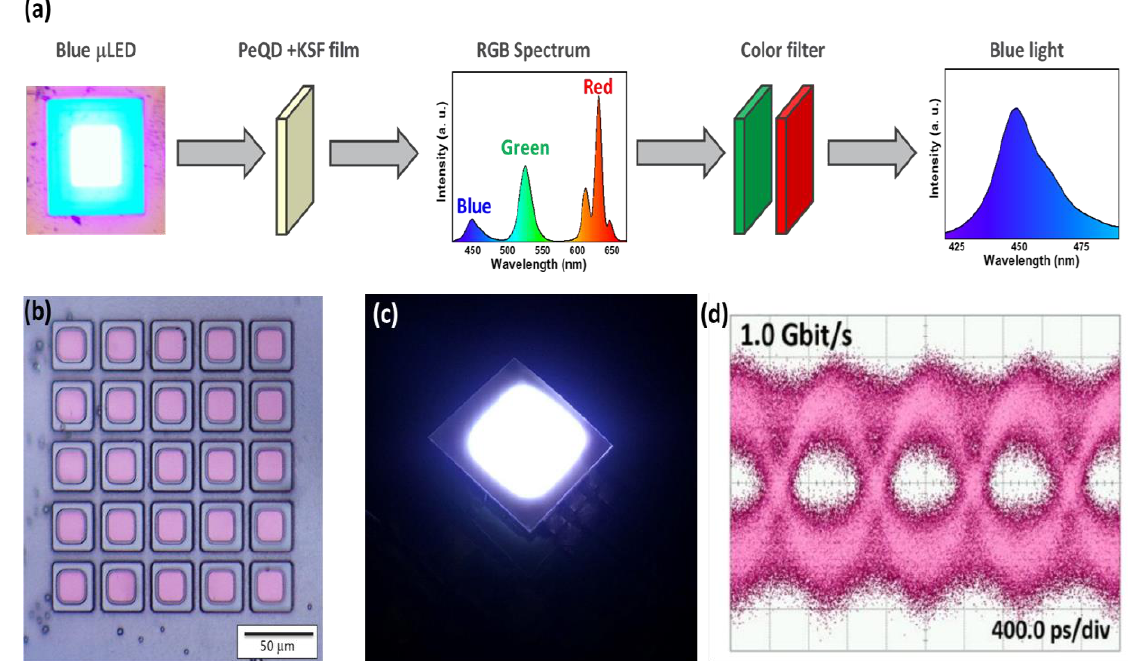
Figure 5. White PeQD composite film VLC application. ( a ) Architecture image. ( b ) Optical microscope (OM) image of 50 μm micro-LED. ( c ) Light color diagram of blue micro-LED combined with white PeQD composite film. ( d ) Detected NRZ-OOK eye diagram at 1 Gbit/s.